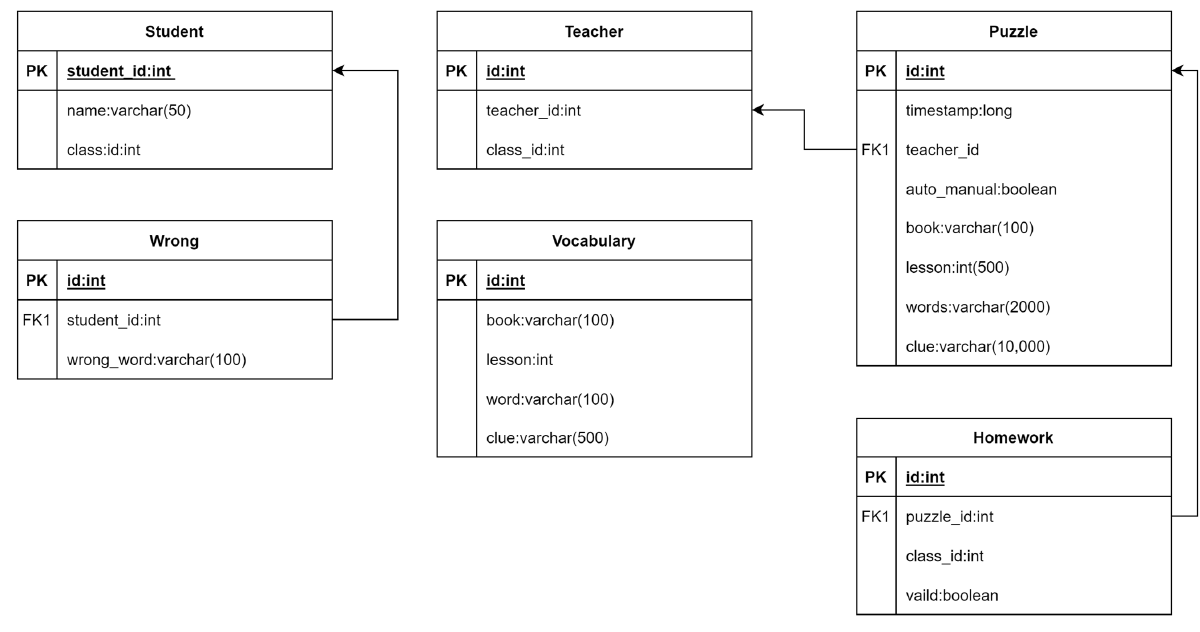
Figure 2. The diagram of the